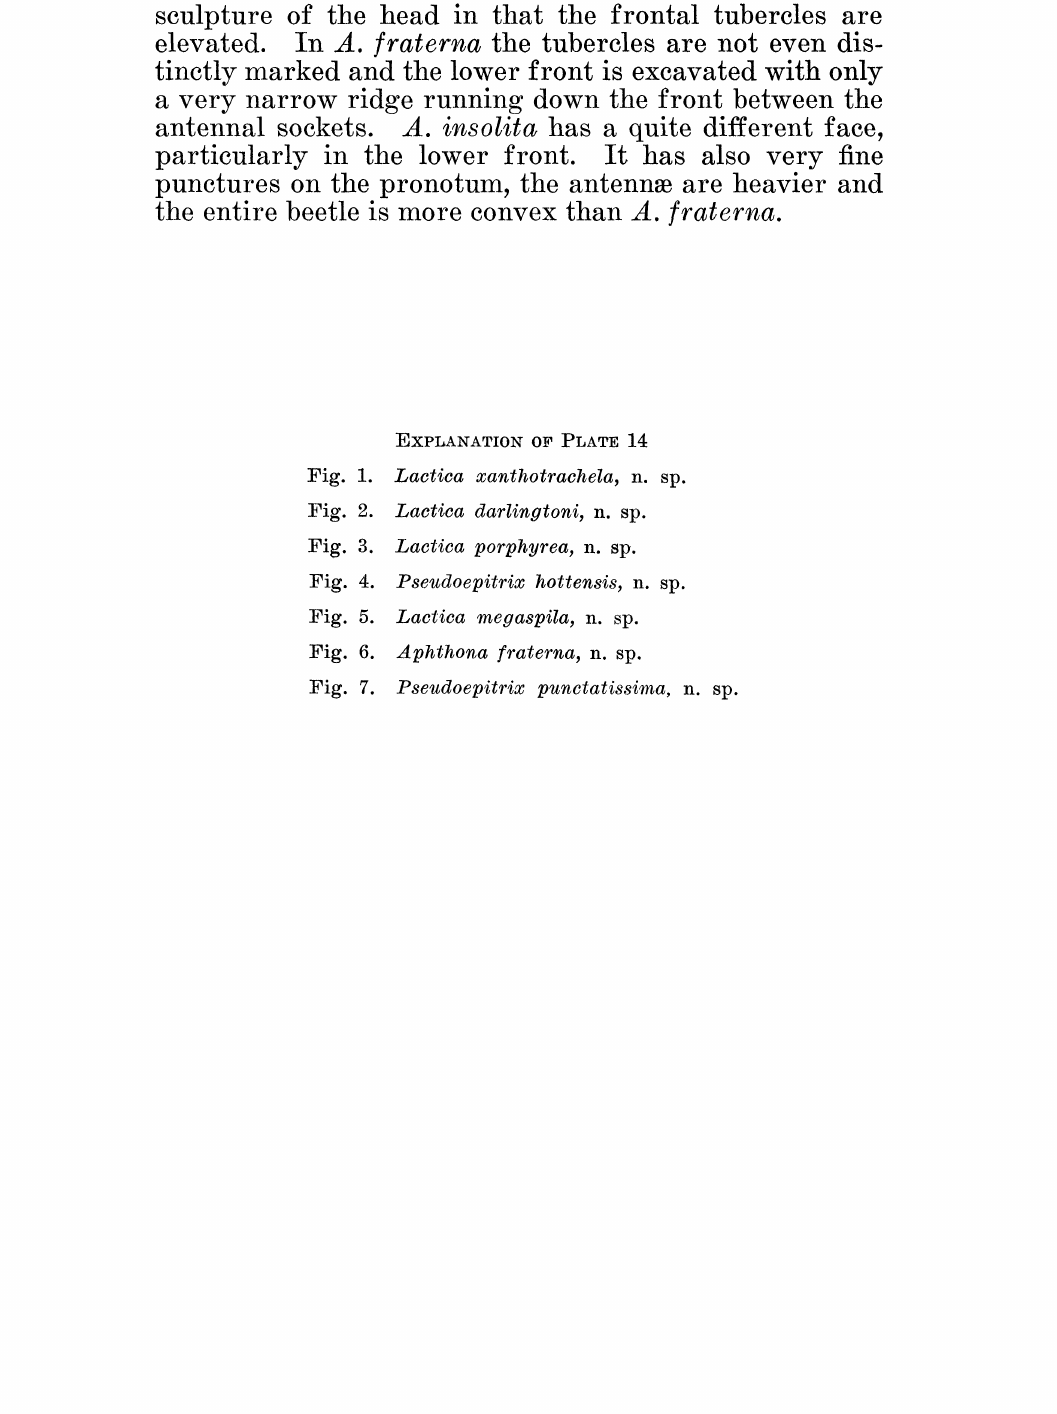
EXPLANATION OF PLATE 14 Lactica xanthotrachela, n. sp. Lactica darlingtoni, n. sp. Lactica porphyrea, n. sp. Pseudoepitrix hottensis, n. sp. Lactica megaspila, n. sp. A phthona fraterna, n. sp. Pseudoepitrix punctatissima, n.